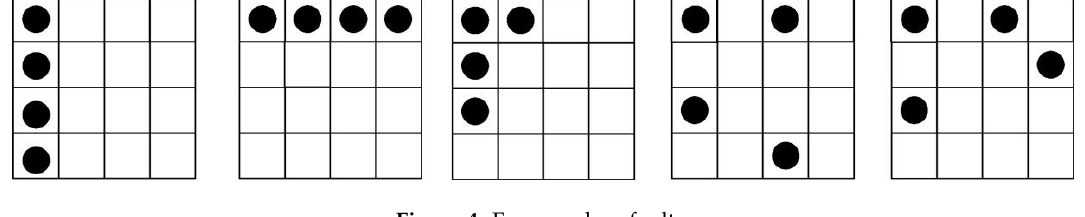
Figure 4. Four random faults.